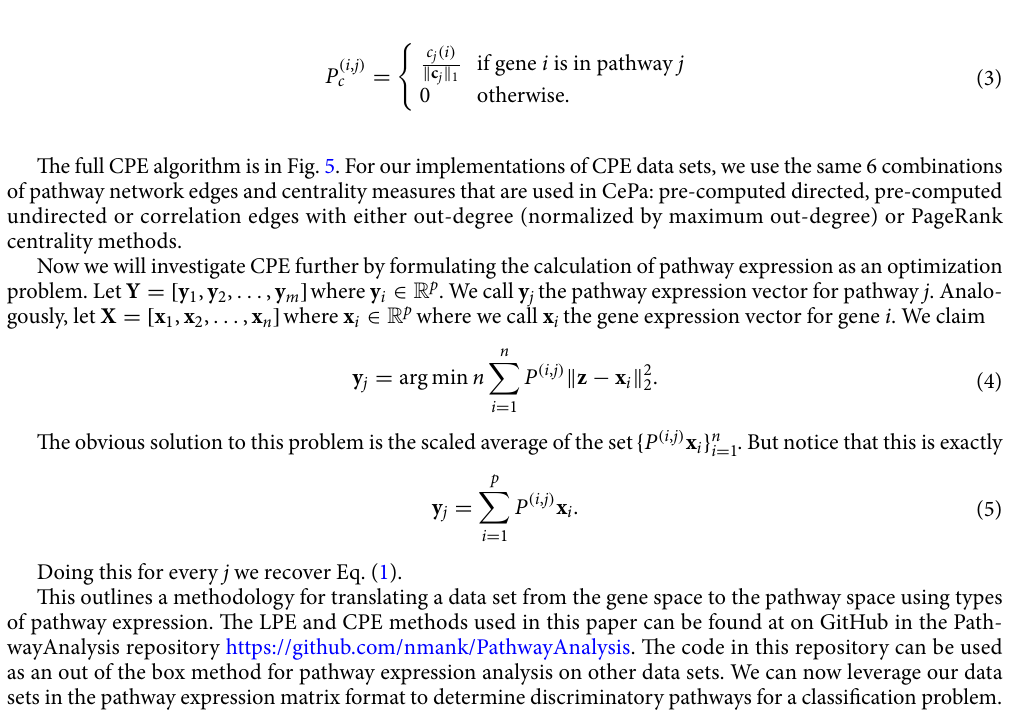
Figure 5. The workflow for